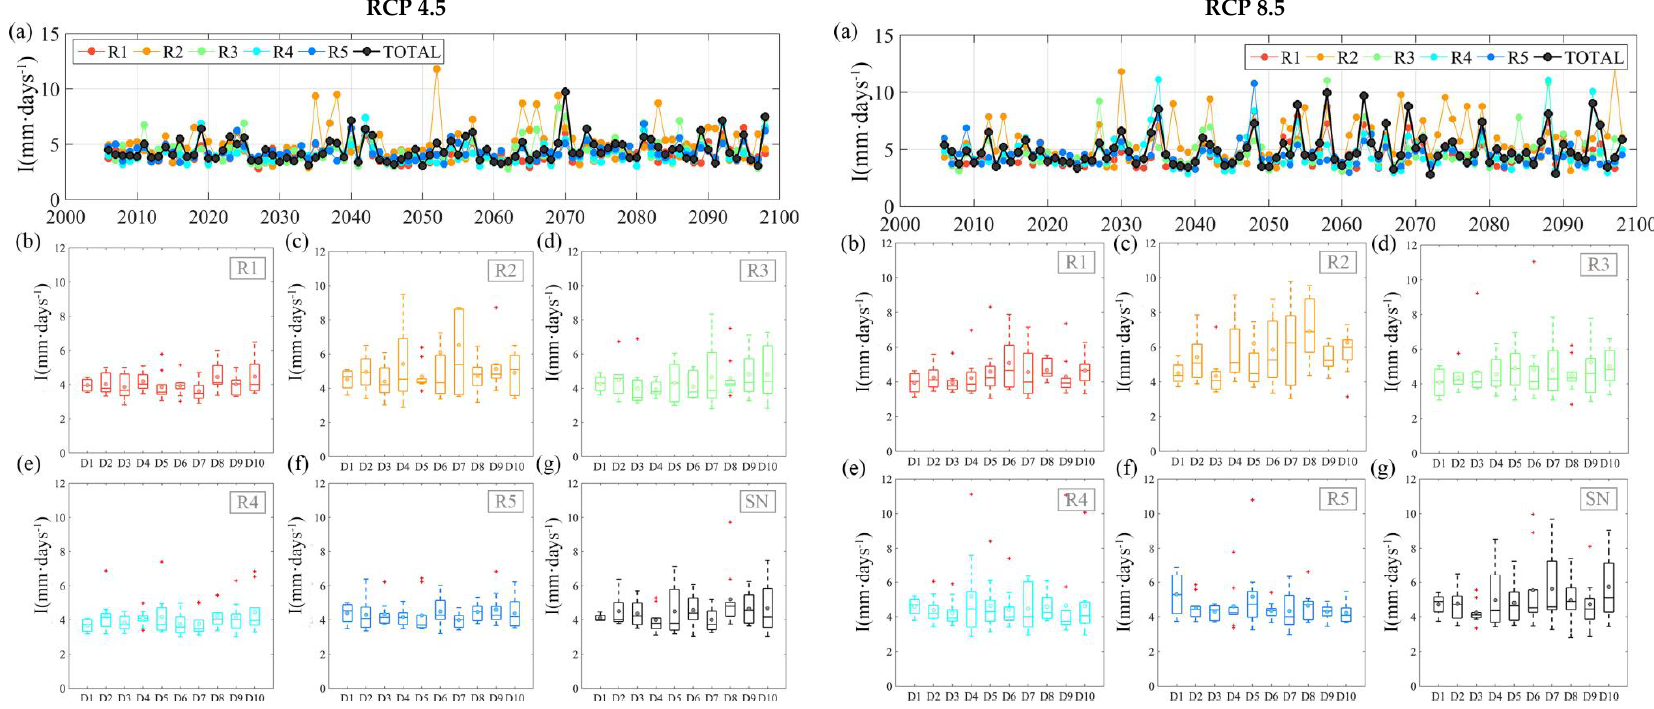
Figure 10. Annual evolution of the annual snowfall intensity (Isnowfall) during the 2006–2100 future study period for ( a ) RCP 4.5 and ( h ) RCP 8.5, averaged over each region in Sierra Nevada (Figure 1) and the whole study area. Decadal evolution of the mean annual snowfall anomalies during the study period in Sierra Nevada for RCP 4.5: ( b ) Region 1, ( c ) Region 2, ( d ) Region 3, ( e ) Region 4, ( f ) Region 5, and ( g ) the total study area, and the decadal evolution for RCP 8.5: ( i ) Region 1, ( j ) Region 2, ( k ) Region 3, ( l ) Region 4, ( m ) Region 5, and ( n ) the total study